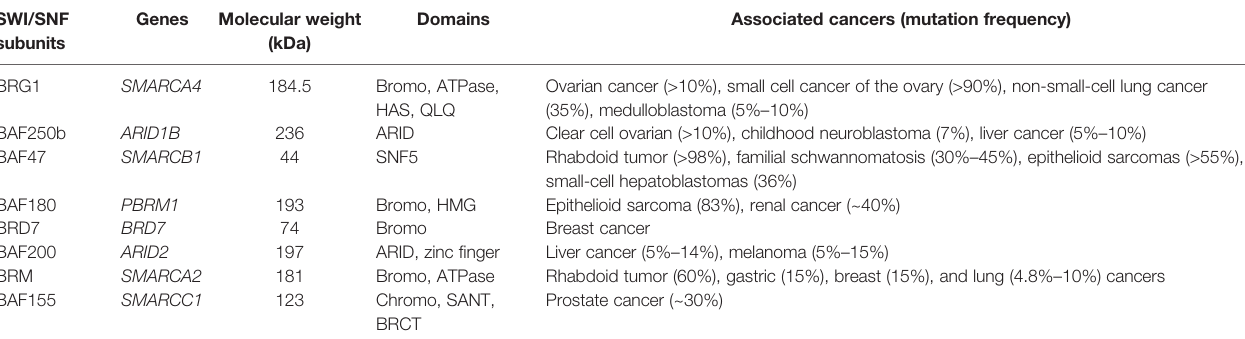
TABLE 3 | Other SWI/SNF members involved in tumorigenesis and